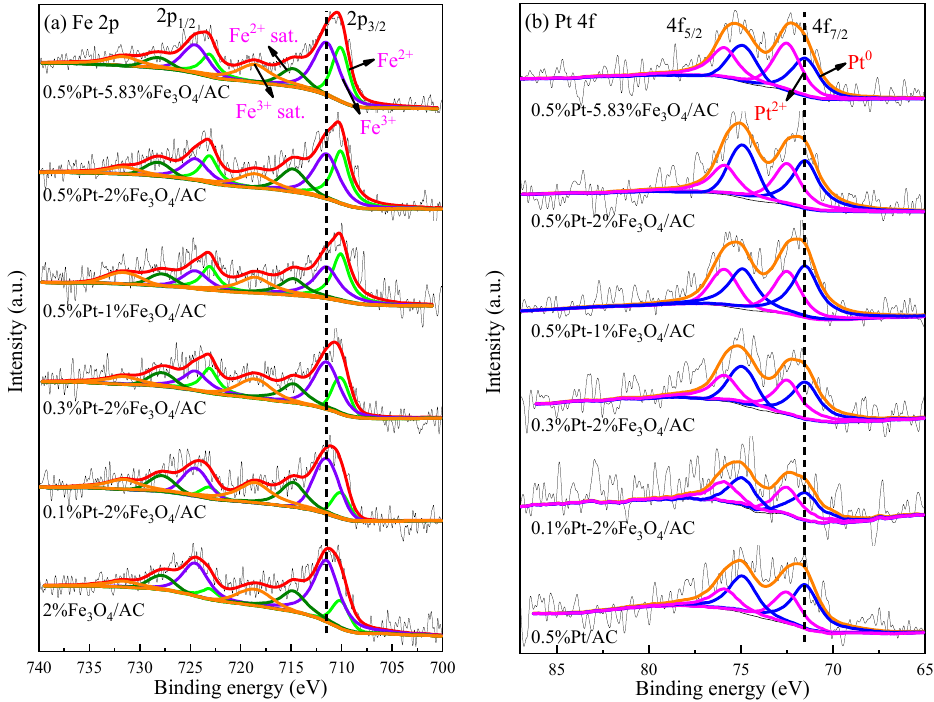
Figure 4. Fe 2p ( a ) and Pt 4f ( b ) XPS spectra of different catalysts. Py–FTIR spectra were used to qualitatively and quantitatively analyze the Lewis and Brønsted acid. The peak at 1545 cm − 1 was assigned to pyridine coordinated to the Brønsted acid sites (B), and the band at 1490 cm − 1 was attributed to the overlap of Brønsted and Lewis acid sites (L) [46]. The characteristic infrared bands of adsorbed pyridine at Lewis acid sites (L) were observed at 1450 cm − 1 and around 1600 cm − 1 [47]. As shown in Figure 5, the catalyst samples contained a large number of Lewis acidic sites, while the Brønsted acidic sites at 1545 cm − 1 were almost unobservable. Moreover, the Lewis acidic sites at 1450 cm − 1 at a desorption temperature of 150 °C were quantified; the data is presented in Table 1. It can be observed that the AC carrier had a certain number of Lewis acidic sites, and that the increase was not significant with the addition of small amounts of Pt or FeO x . However, there was an obvious increase in Lewis acidic sites after the introduction of